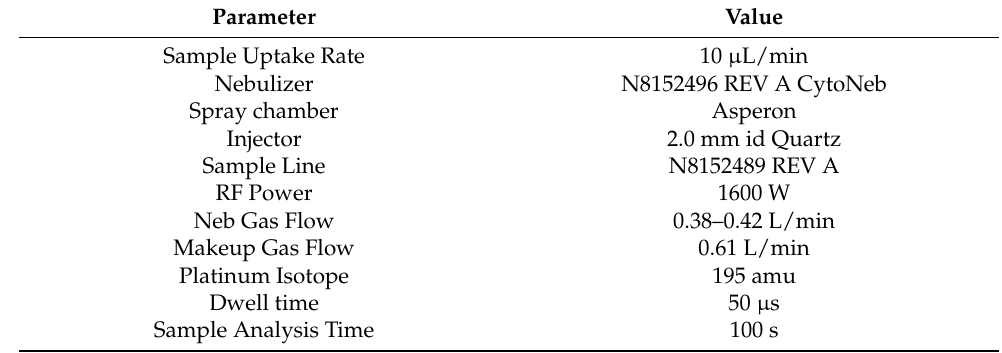
Table 1. SC-ICP-MS